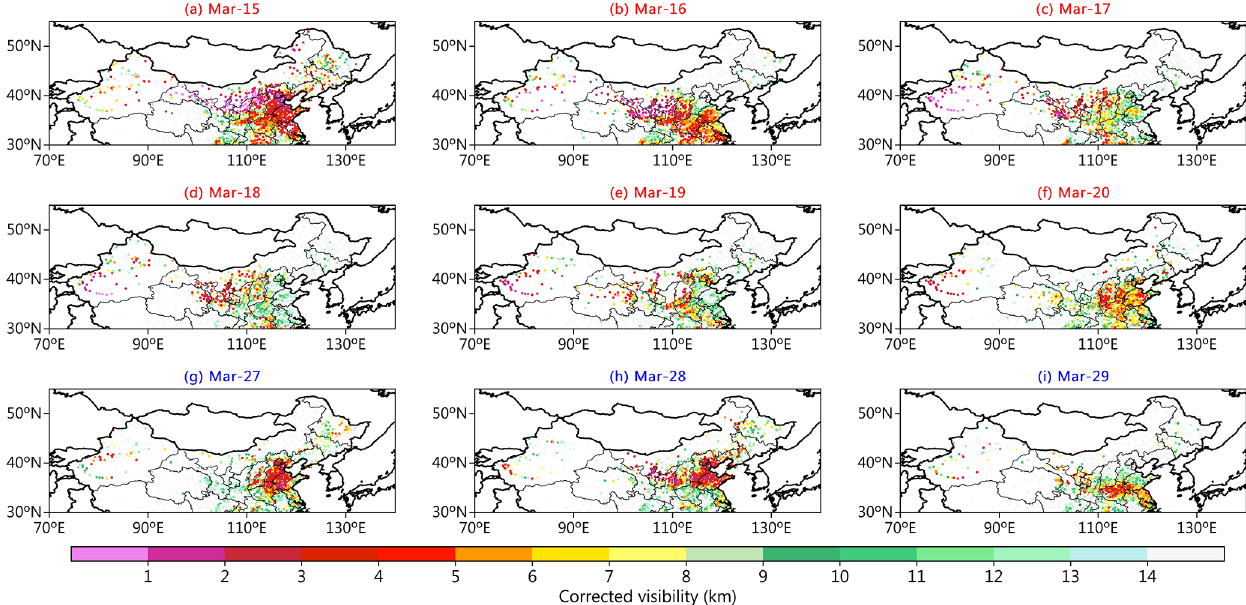
Figure 3. Evolution of observed daily mean (presented as averages close to the MODIS and VIIRS observation time range, i.e., approxi- mately 10:00 to 14:00CST) corrected visibility during (a–f) the 3.15 SDS event (15–20 March 2021) and (g–i) the 3.27 SDS event (27–29 March 2021),